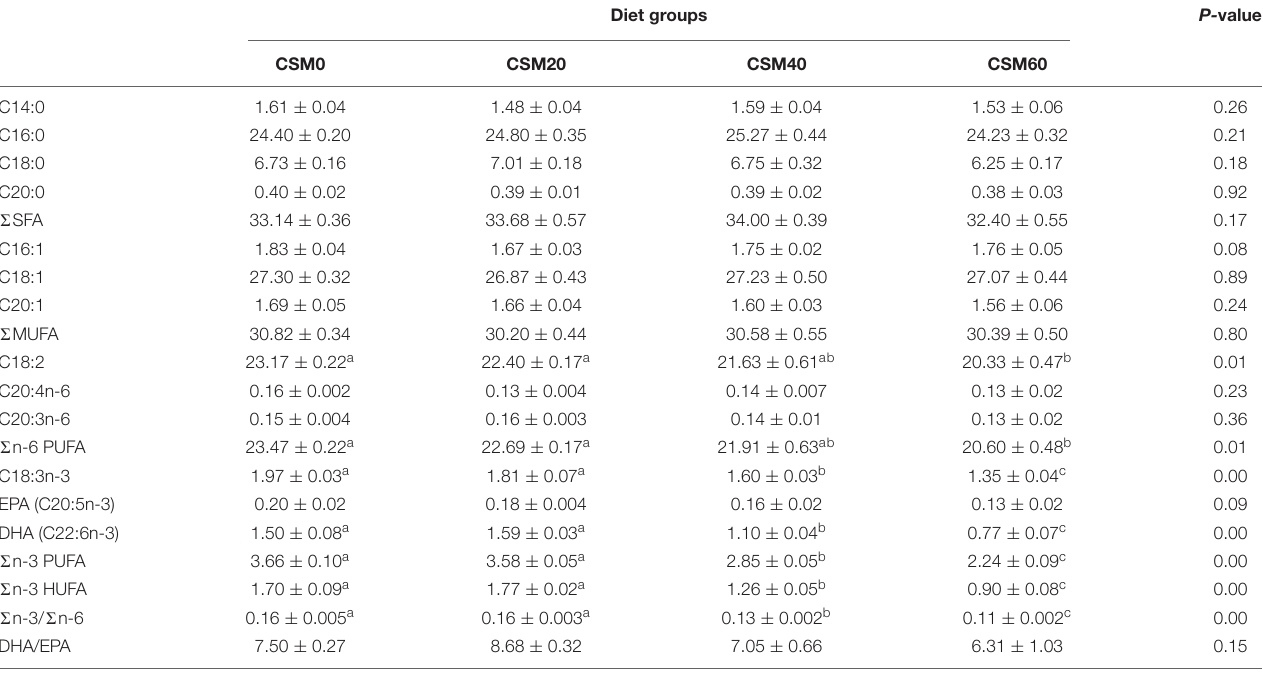
TABLE 8 | Whole body fatty acids content (% total fatty acids).